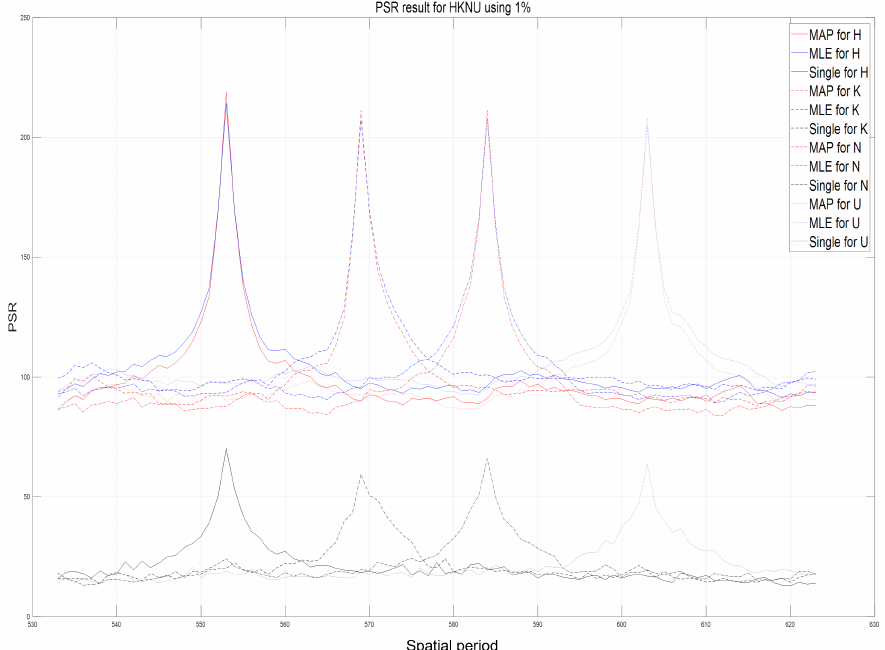
Figure 14. Peak sidelobe ratio (PSR) results of HKNU objects via various spatial periods at reconstruc- tion depths by single observation photon counting method, N = 100 observation MLE, and N = 100 observation MAP with 1% photon ratio.